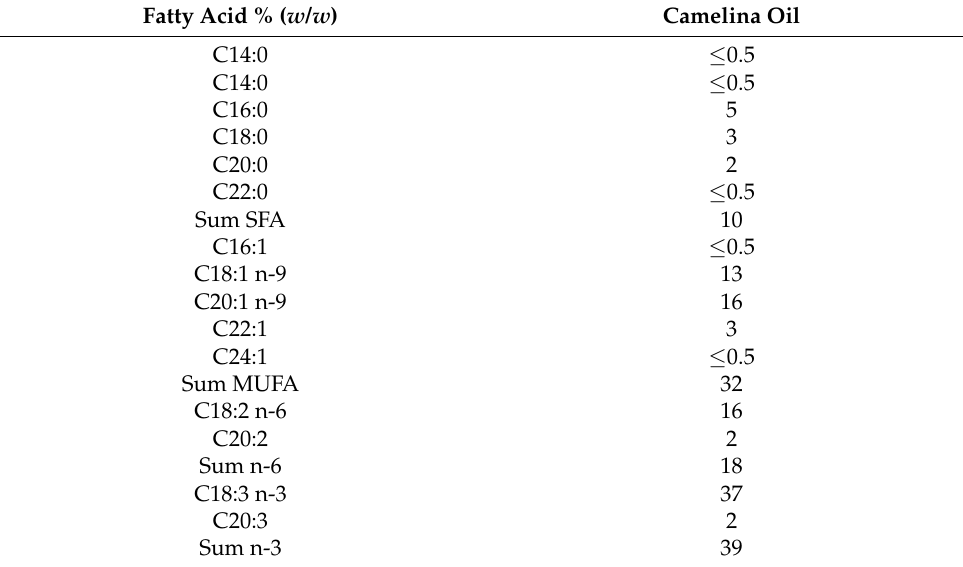
Table 1. Fatty acid composition of camelina oil (% of total fatty acids). Fatty Acid % ( w / w )